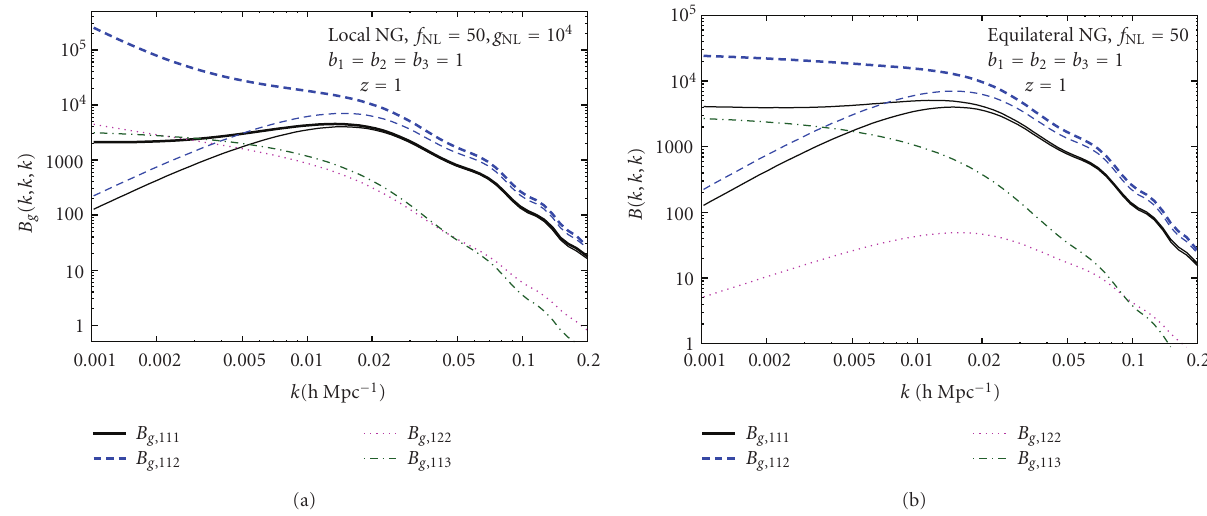
Figure 21: Large-scale contributions to the galaxy bispectrum due to primordial non-Gaussianity of the local (a) and equilateral (b) type described as one-loop corrections assuming a local bias prescription. Thin lines correspond to the contributions for Gaussian initial conditions, from the study by Sefusatti in [171]; see the reference for further